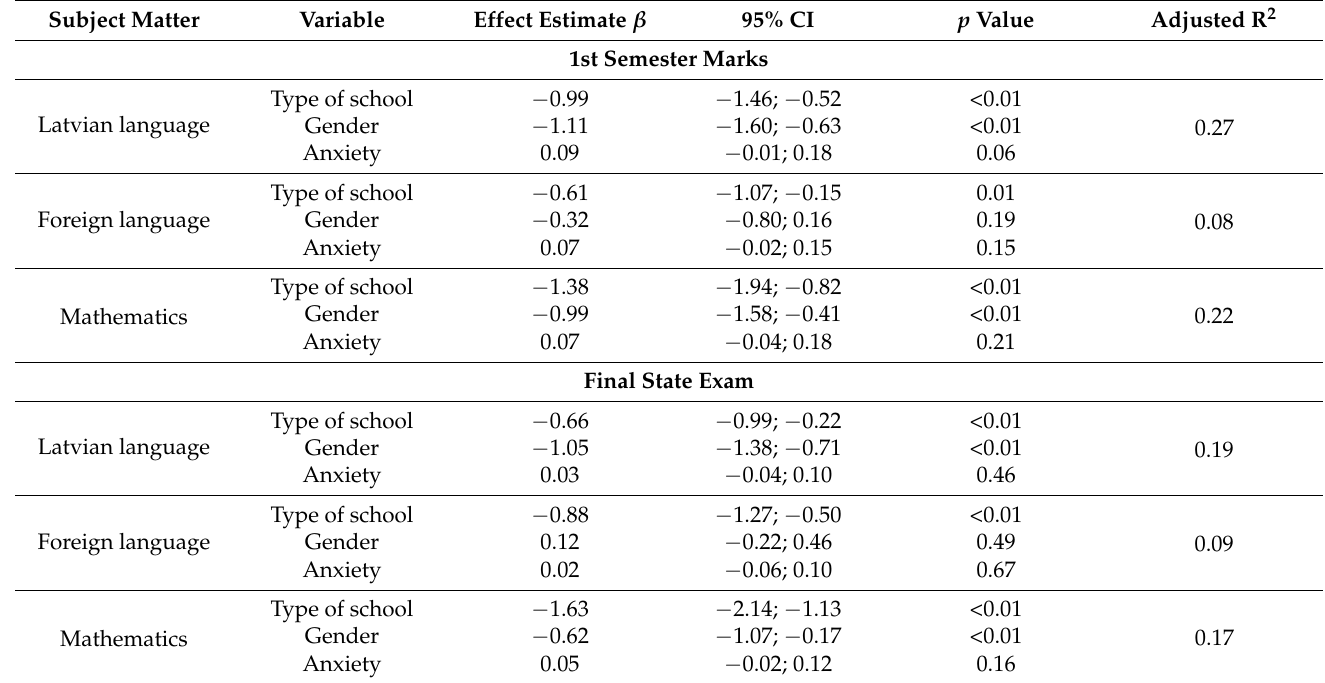
Table 5. Association between students’ marks, type of school, gender, and